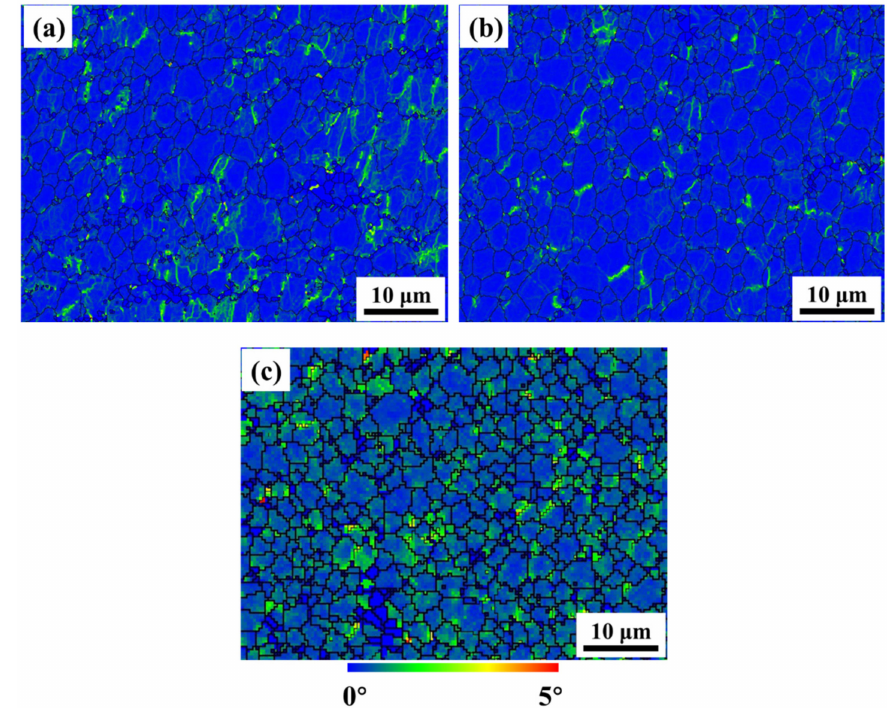
Figure 8. Kernel Average Misorientation (KAM) maps of alloys processed by ( a ) 623 K-4P, ( b ) 623 K-12P and ( c ) 573 K-12P.